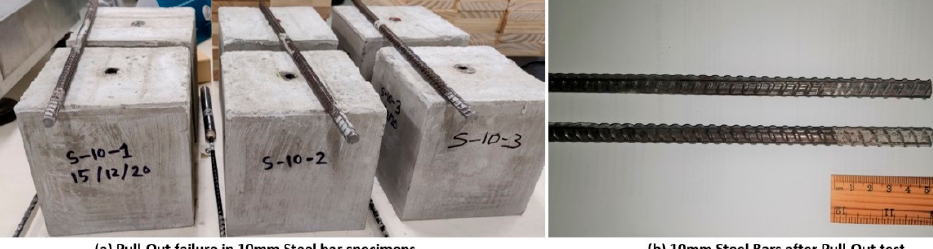
Figure 13 . Pull-out failure of steel bar specimens.